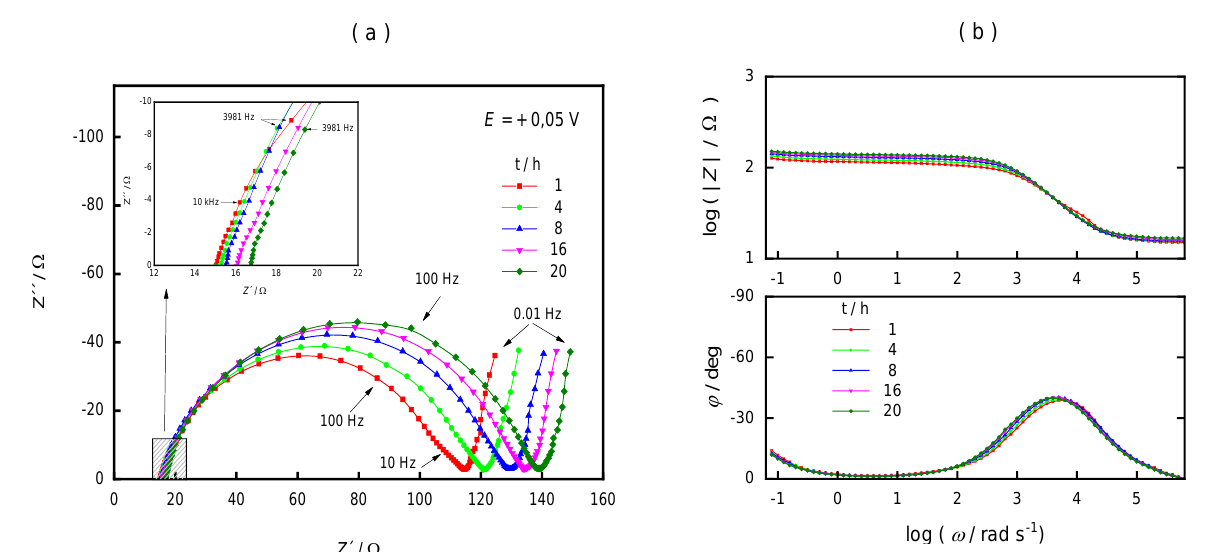
Figure 13. Time-dependance PEIS spectra of HCSi20 with FEC cell at +0.05 V in ( a ) Nyquist plot, ( b ) Bode plot.